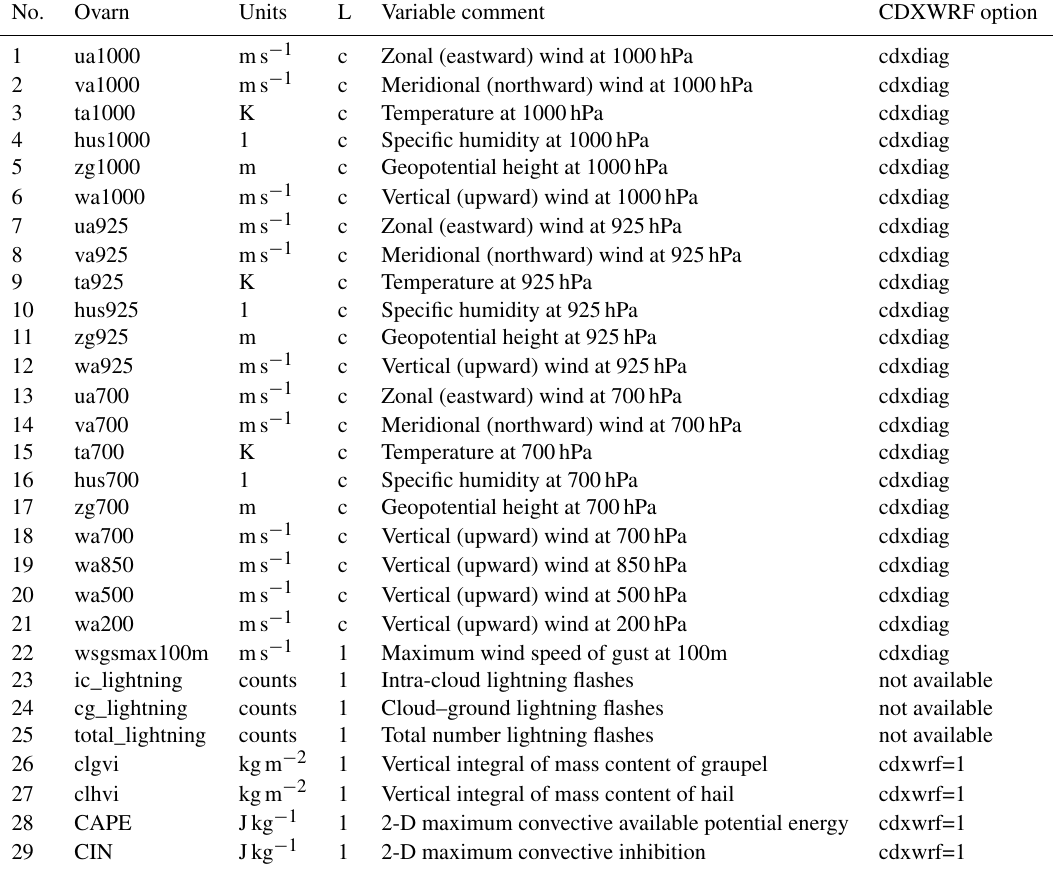
Table A2. As in Table A1, but for the additional variables requested by the CORDEX FPS_Alps experiment.